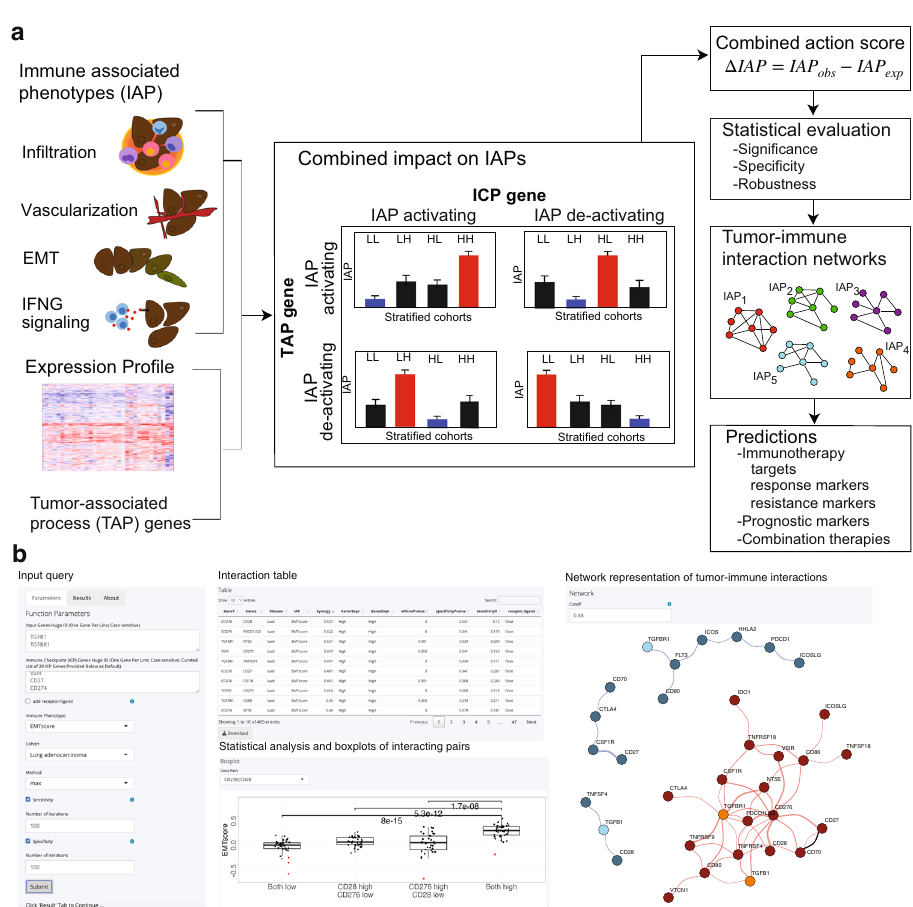
Fig. 1 Overview of Imogimap. a Immune-associated phenotype (IAP) levels and mRNA expression values are the inputs to ImogiMap. Based on the variation in IAP levels across patients, the algorithm calculates combined action scores between tumor-associated processes (TAP) that may constitute a functional gene signature and therapeutically actionable immune checkpoint (ICP) genes. For each TAP-ICP gene pair, the patient cohort is strati fi ed into four sub-cohorts (LL, LH, HL, HH), and IAP levels are measured within each sub-cohort. A baseline sub-cohort (marked blue) and a target group (marked red) are determined based on four null assumptions on the relationship of the two genes with the IAP (both activating, both deactivating, and